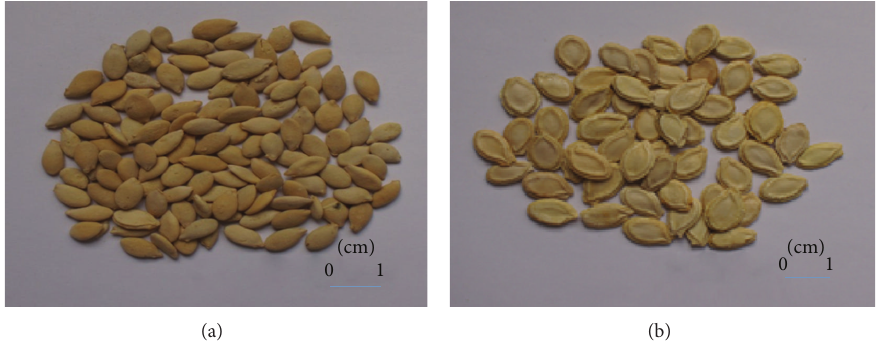
Figure 1: Benincasa hispida seeds. (a) Unilateral. (b) Bilateral (much more